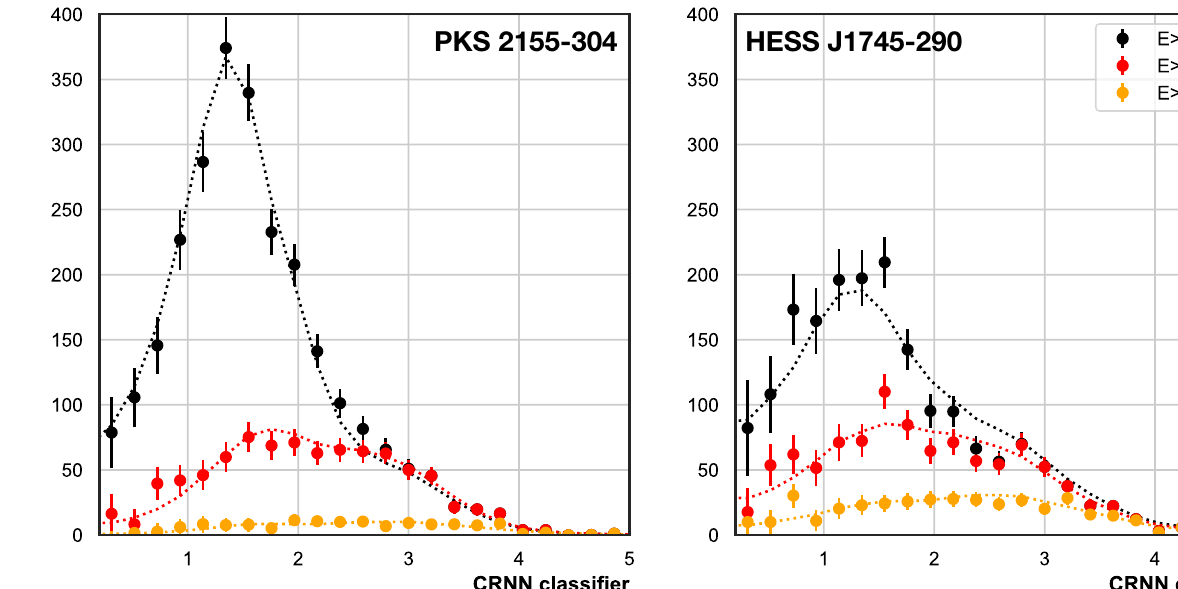
lations re-weighted to match the source spectrum index with 100 and 200MHz NSB level respectively, and scaled to number of excess events in each energy